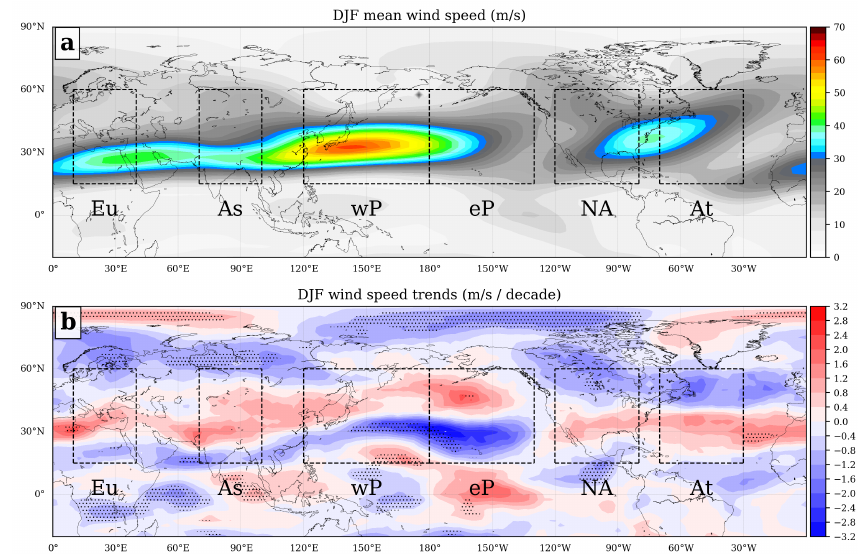
Figure 1. Winter (DJF) wind speed and wind speed trends between 400 and 100 hPa for the period from 1981 to 2012 following the methodology of Archer and Caldeira [18] with data from the National Centers for Environmental Prediction (NCEP) Reanalysis [57]. ( a ) Wind speed. ( b ) Wind speed trends. Domains regions for the calculation of descriptive STJ indices are enclosed in black boxes and labeled with their name abbreviations. Eu: Europe (10–40 W), As: Asia (70–100 W), wP: Western Pacific (120–180), eP: Eastern Pacific (180–130 E), NA: North America (120–80 E) and At: Atlantic (70–30 E). Dotted areas show statistical significant trends with 95% confidence